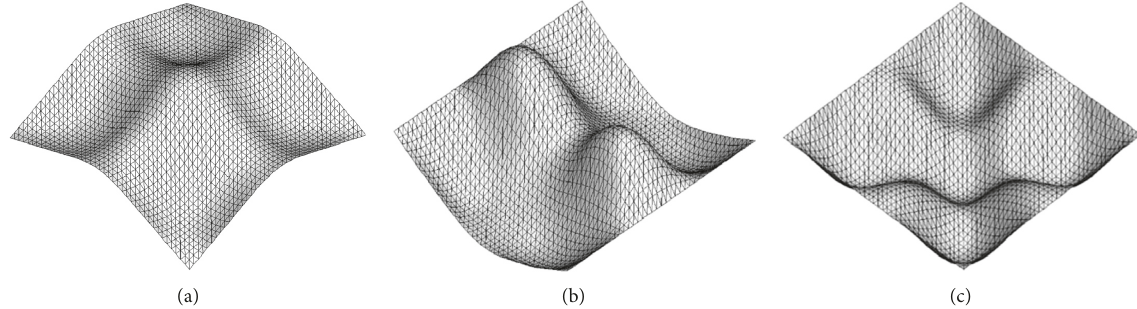
Figure 7: Optimal shapes and stacking sequences obtained by simultaneous optimization in Example 1. (a) Shell 1 [ − 45 ° /90 ° /45 ° /90 ° /45 ° (b) Shell 2 [90 ° /0 ° / − 45 ° 2 /45 ° / − 45 ° /90 ° /0 ° ] s ; (c) Shell 3 [ − 45 ° /90 ° /45 ° 2 /90 ° / − 45 ° /0 ° /45 ° ] s .